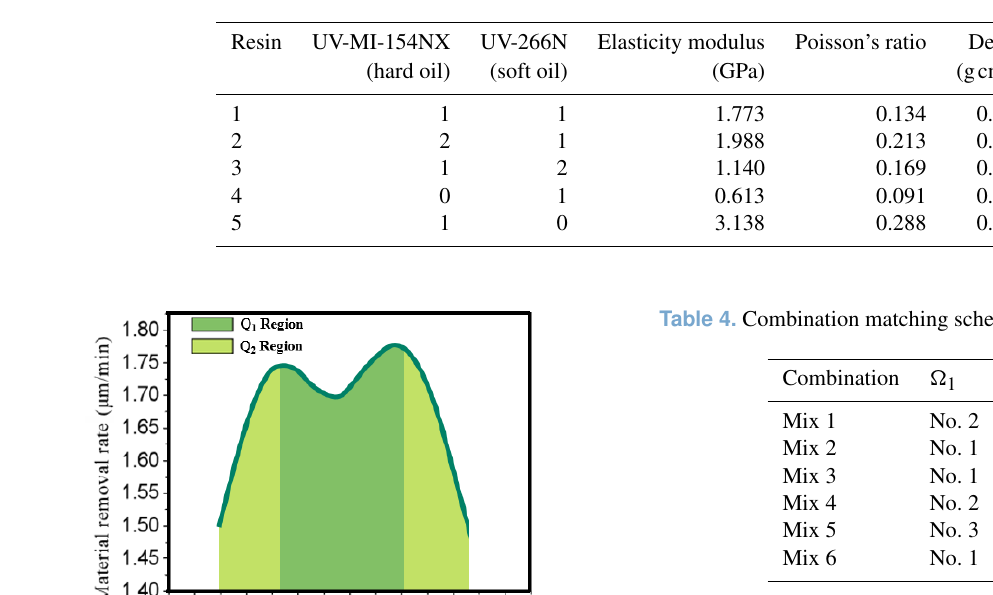
Table 3. Performance parameters of resin materials.